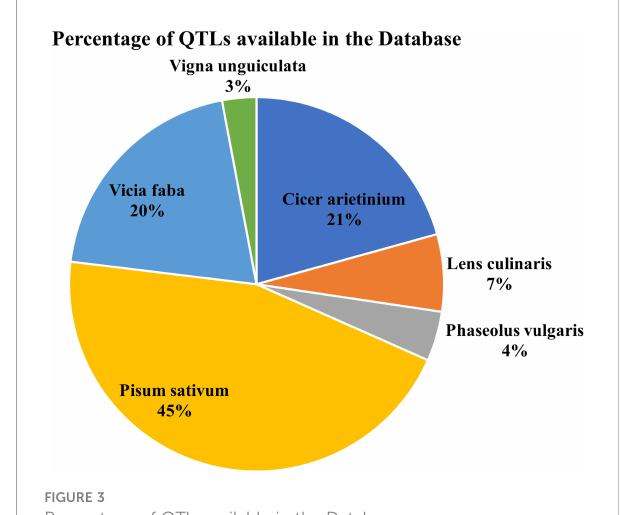
FIGURE 3 Percentage of QTls available in the